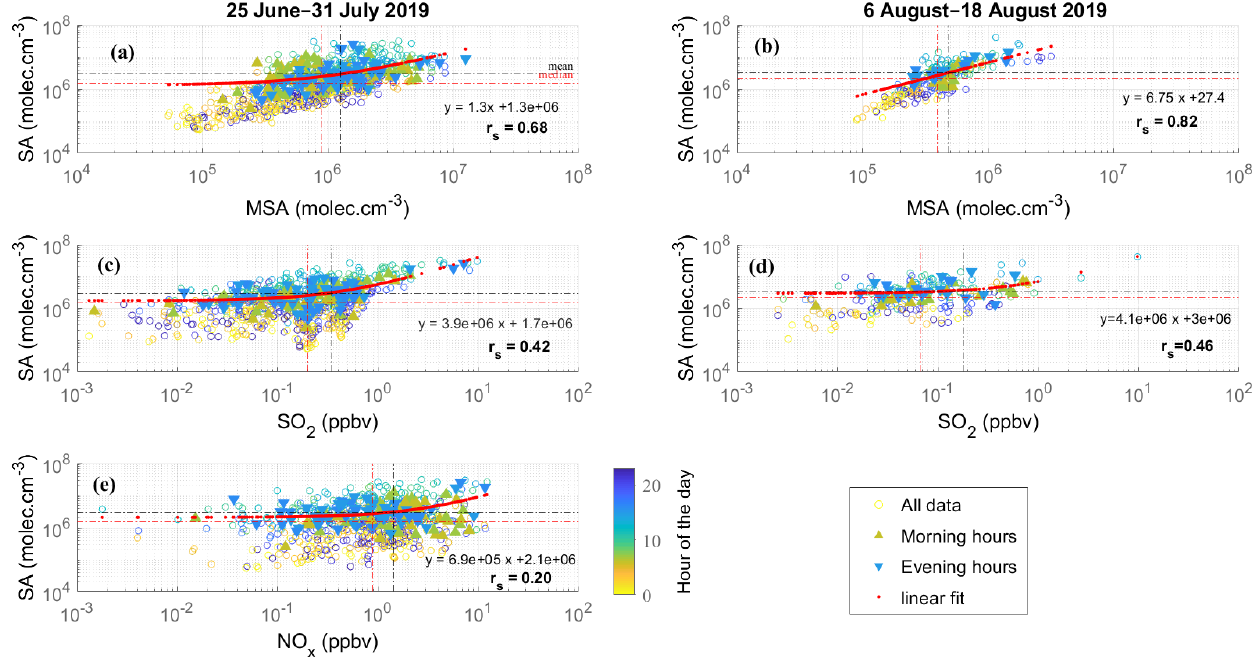
Figure 4. Correlation of SA with MSA (a, b) , SO 2 (c, d) and NO x (e) for June–July. The black dashed lines for both axes represent the mean of the gas concentration; red dashed lines represent the median value of the gas concentrations; and red solid lines represent the linear fit. Spearman’s coefficient ( r s ) was used to test the correlation, at a significance level of 0.001. The circles represent data points at different hours of the day. The upward-pointing green triangles represent the morning rush hours (06:00–08:00), and the downward-pointing blue triangles represent the evening rush hours (15:00–17:00). The yellow hollow circles represent all data. NO x data were unavailable for